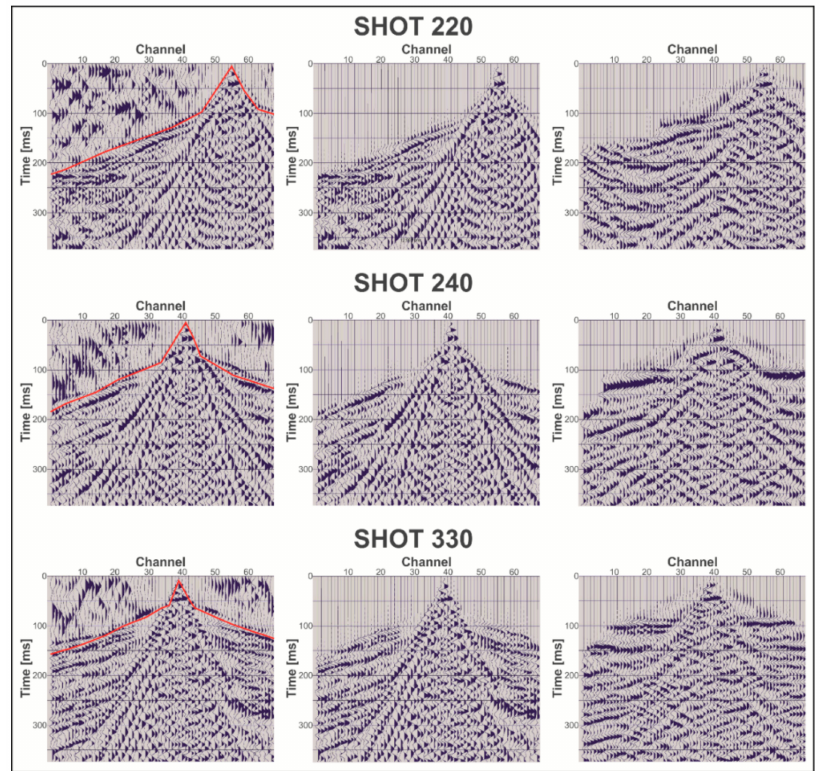
Figure 2. Shot gathers for shots 220, 240, and 330 with applied automated gain control (AGC) (100 ms). Left panels: shot gathers after diversity stacking. A carefully designated front mute (red line in left panels) removing linear refraction arrivals is presented in the middle panels. Right panels show the e ff ect of applying normal move-out (NMO). Clear shallow reflections were visible at approximately 120 ms for shot 220, 110 and 140 ms for shot 240, and 100 and 150 ms for shot